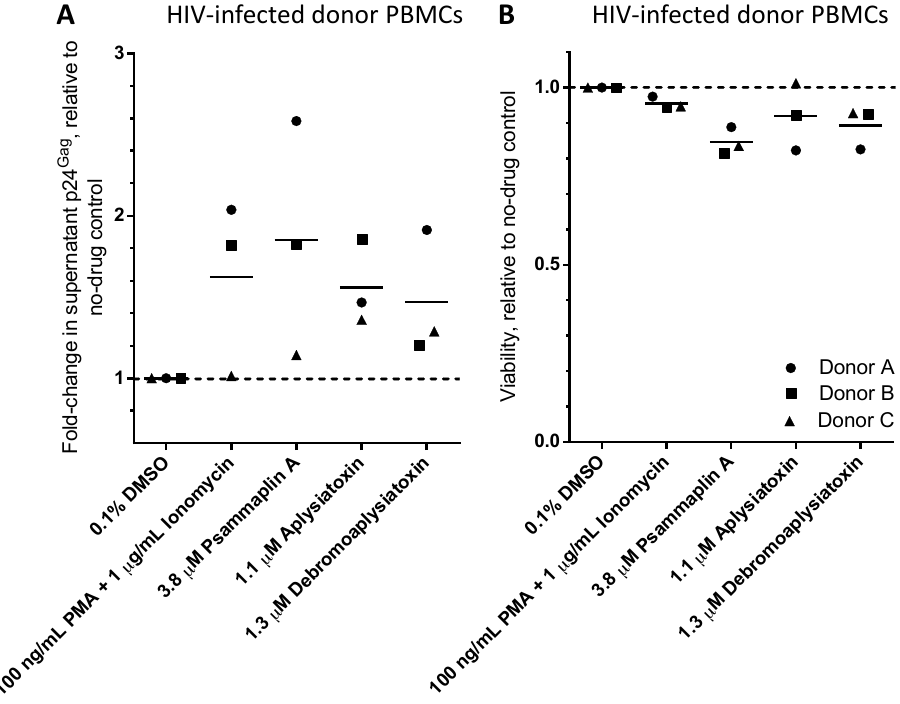
Figure 4. Effects of LRAs on peripheral blood mononuclear cells (PBMCs) from three HIV-infected